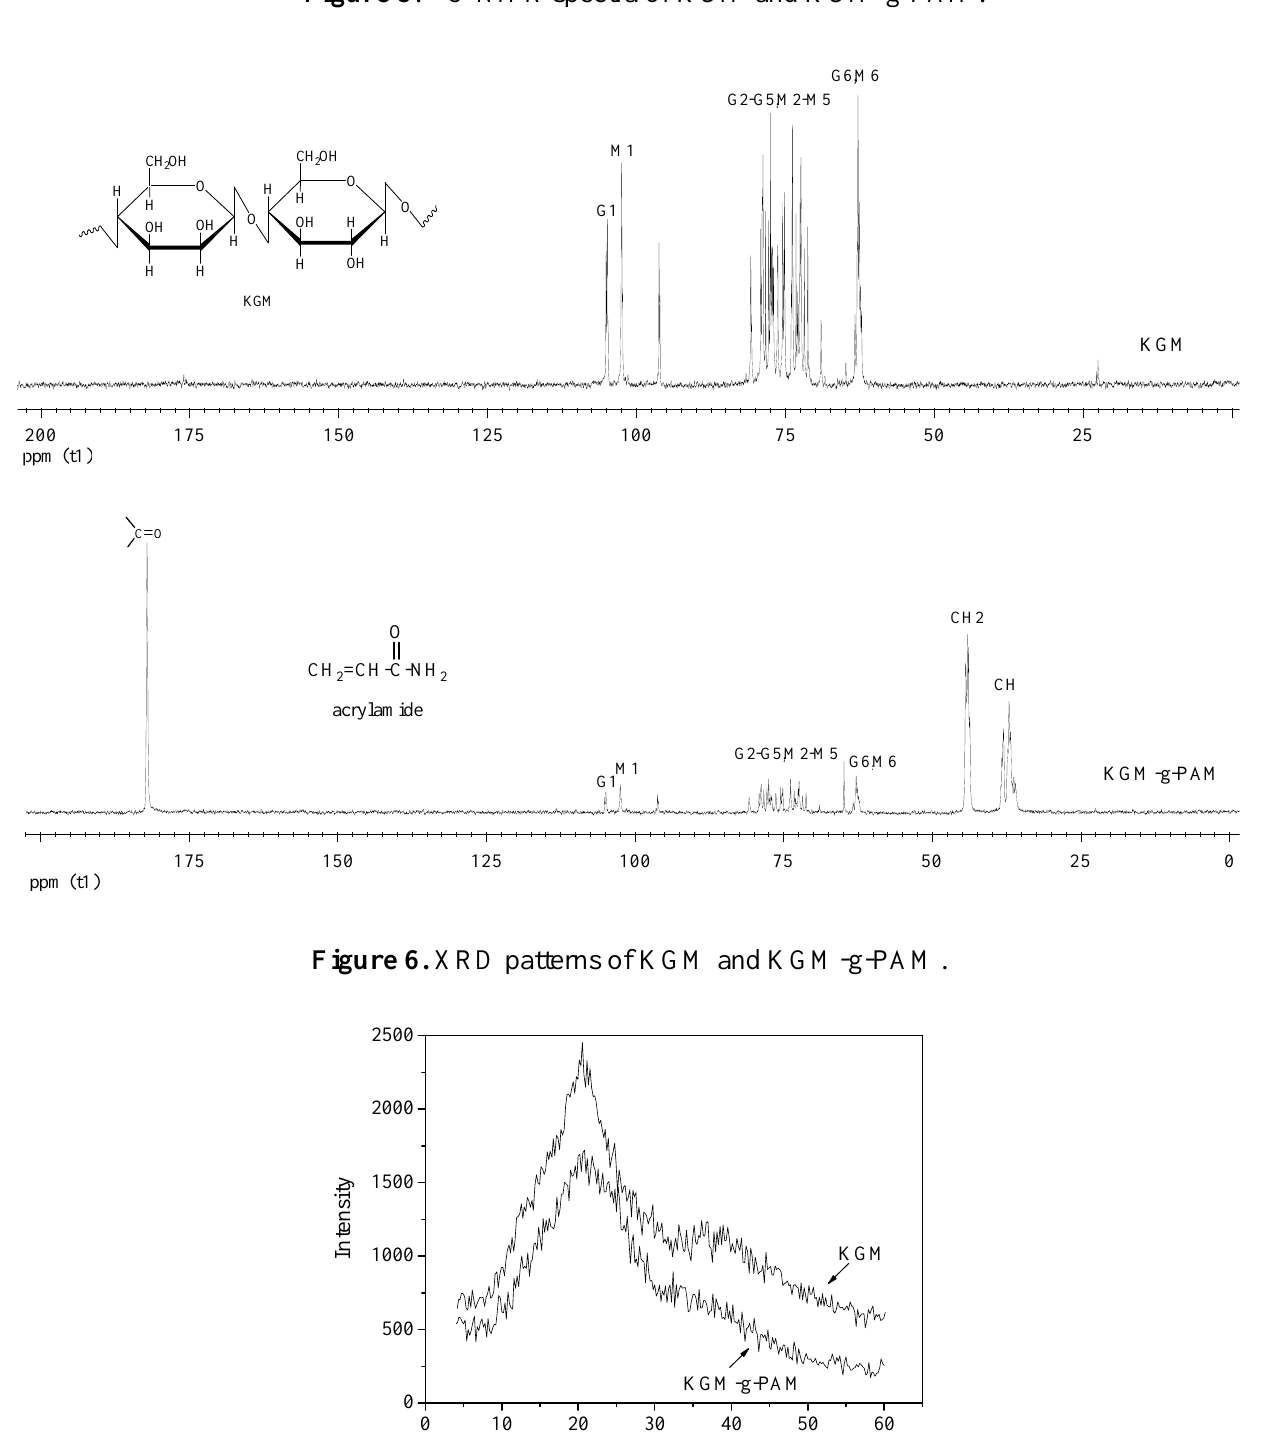
Figure 5 . 13 C-NMR spectra of KGM and KGM-g-PAM.